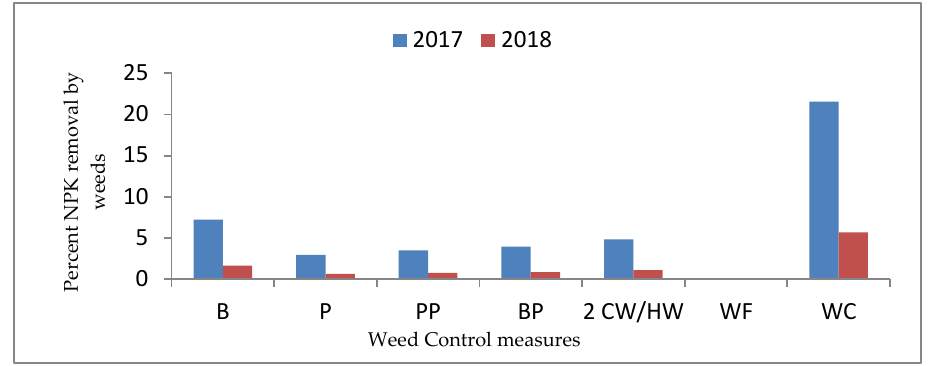
Figure 3. Proportion of nutrient uptake by weeds from total uptake (plants + weeds NPK uptake) under crop establishment techniques.